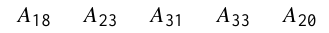
Table 17. The options ranking. A 18 A 23 A 31 A 33 A